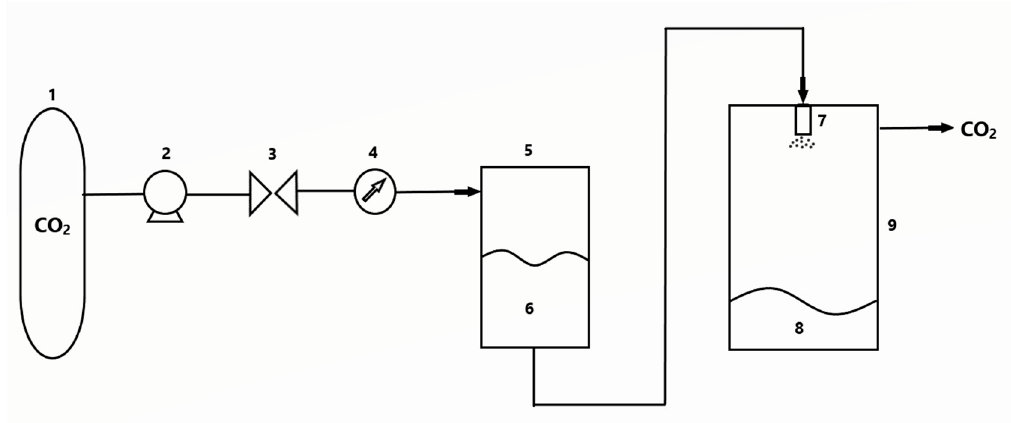
Figure 6. Particles from a gas-saturated solution (PGSS) process installation diagram. Legend: (1) CO 2 tank; (2) pump; (3) valve; (4) temperature control; (5) static rotor; (6) carrier and active substance mixture; (7) nozzle; (8) powder/product; (9) tank.